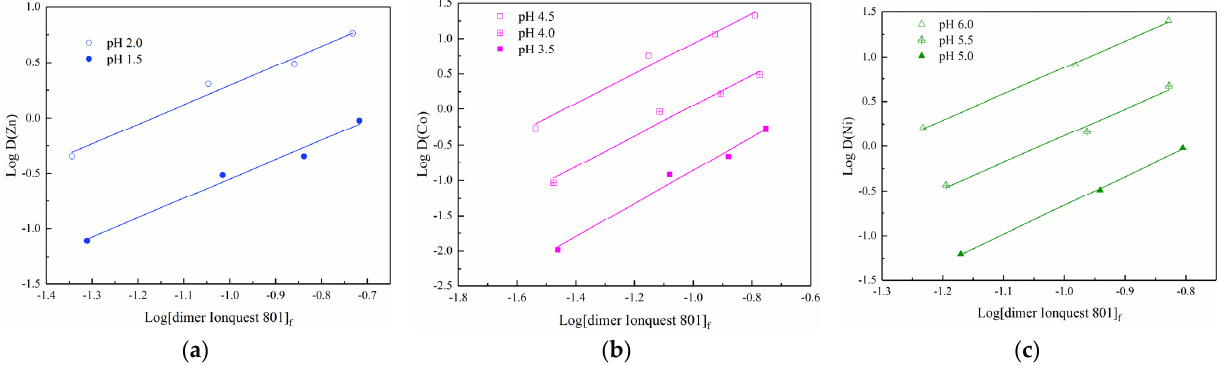
Figure 2. The relationship of Log D ( M ) against Log [dimer Cyanex 272] f . ( a ) Log D(Zn)-Log[dimer Cyanex 272], ( b ) Log